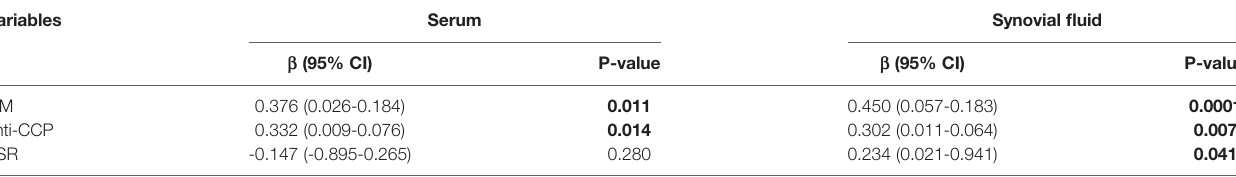
TABLE 3 | Multivariate regression analysis predicting IL-40 levels in the serum and synovial fl uid of RA patients based on laboratory parameters (cohort 1).